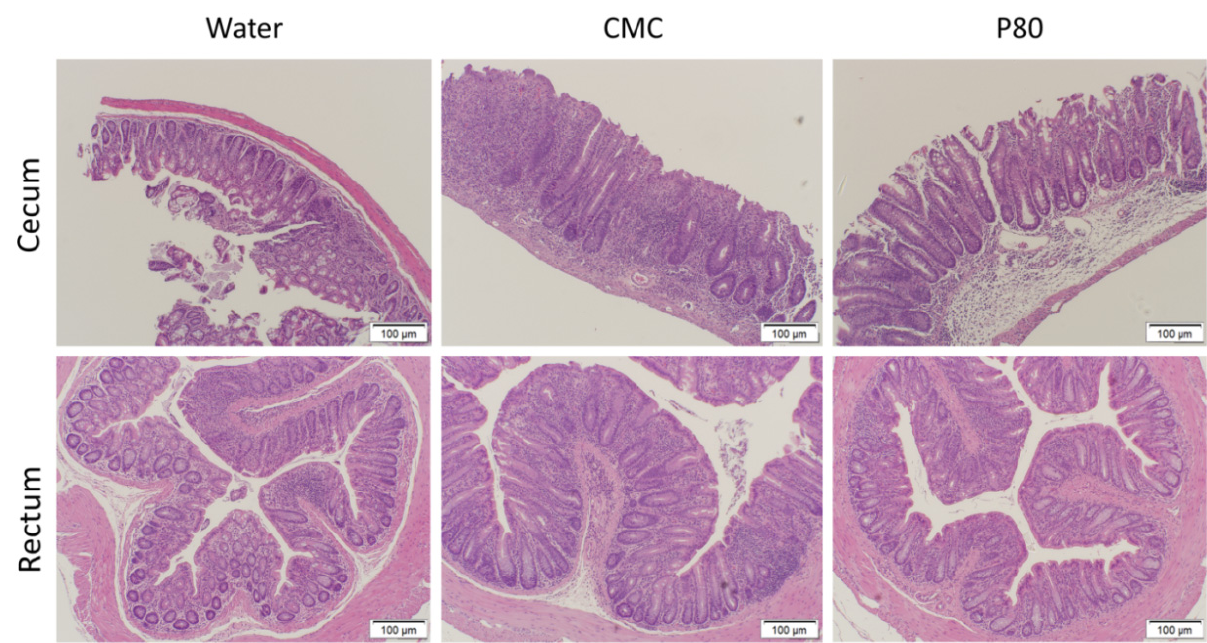
Figure 4. Representative histologic slides of the cecum and rectum stained by hematoxylin-eosin in humanized IL10 − / − mice after 31 days exposure to CMC (1% w / v ), P80 (1% v / v ), and water (control). Scale bar = 100 µm.